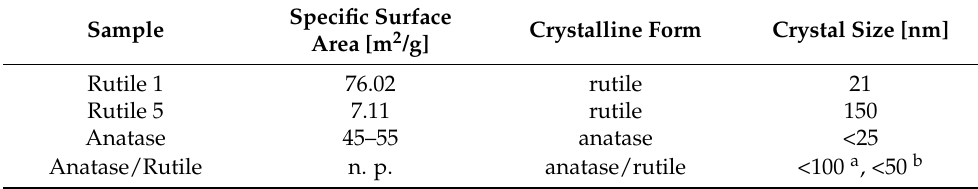
Table 1. Specification of TiO 2 particles used in the study as given by